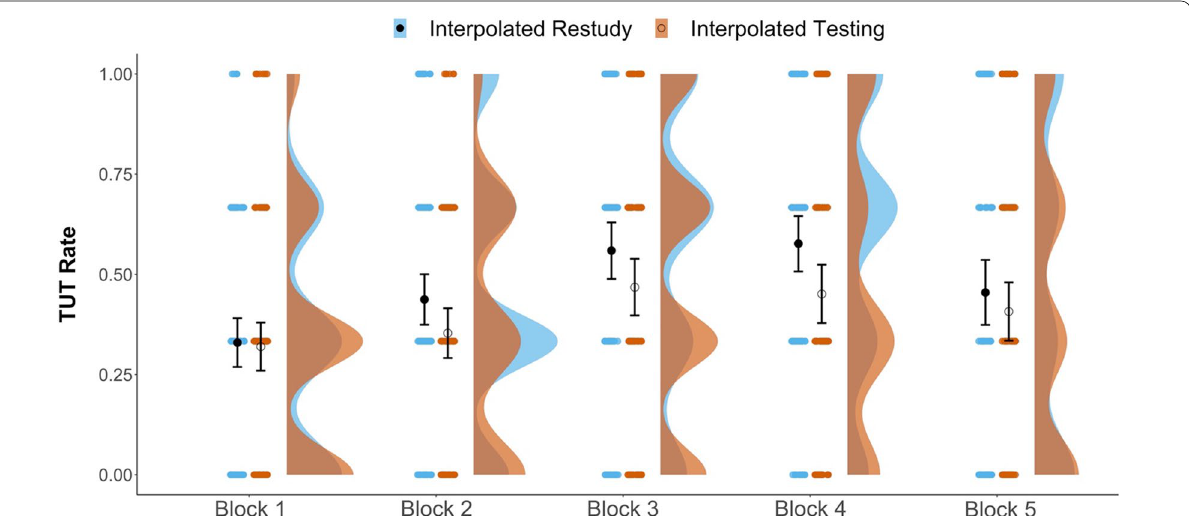
Fig. 4 Raincloud plots depicting TUT rates (the proportions of thought reports indicating TUTs) by block in each interpolated activity condition. Dots represent individual subjects’ TUT rates. The closed black dots represent group-level mean estimates for the Restudy conditions; open circles represent the group-level mean estimates for the Testing conditions. Error bars are 95% confidence intervals